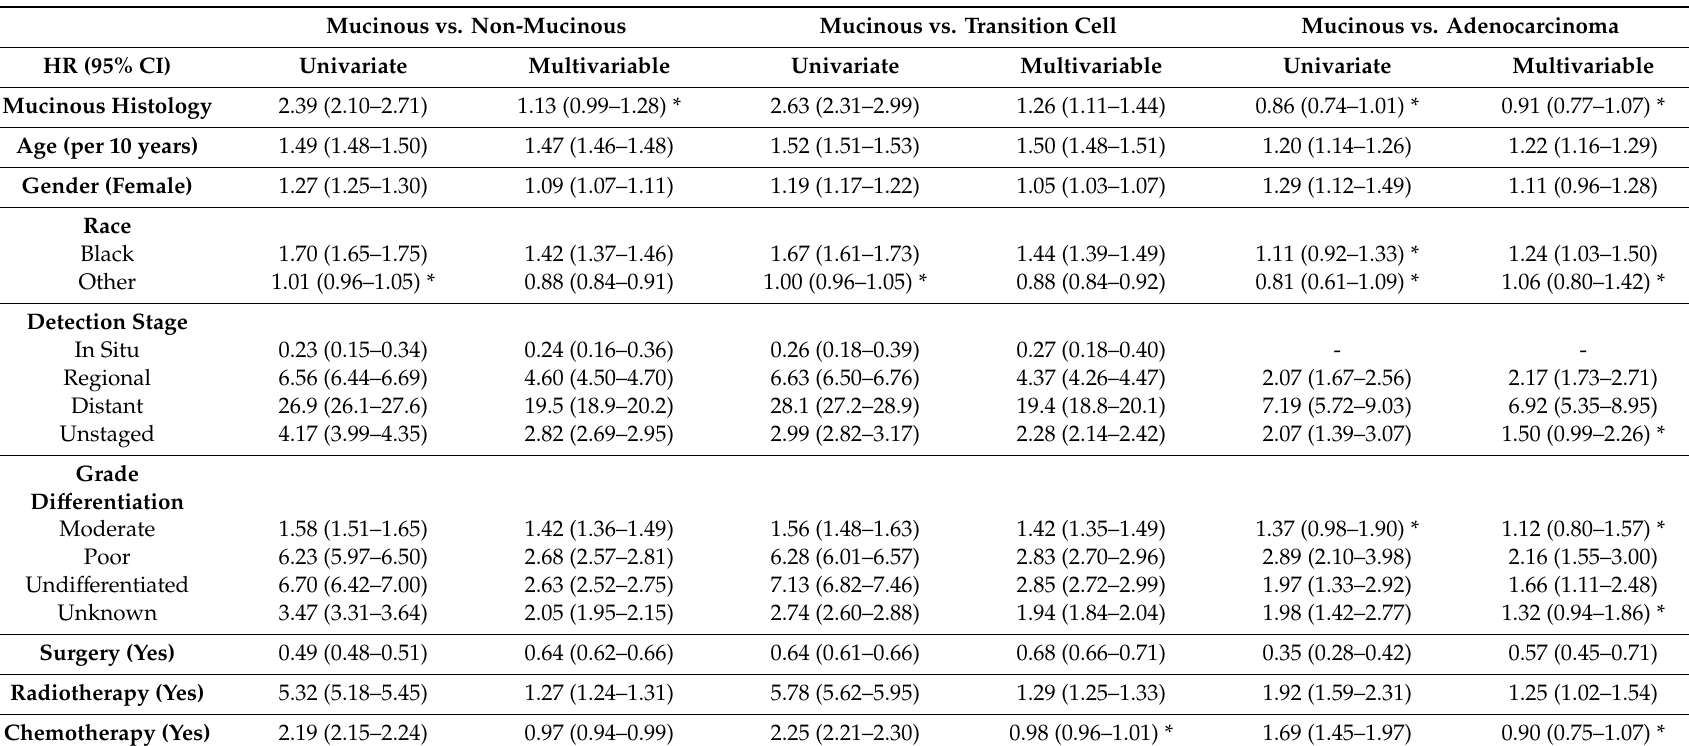
Table 24. Derived univariate and multivariable Cox-proportional hazard ratios (HR) of mortality for urinary bladder cancers. Mucinous vs. Non-Mucinous Mucinous vs. Transition